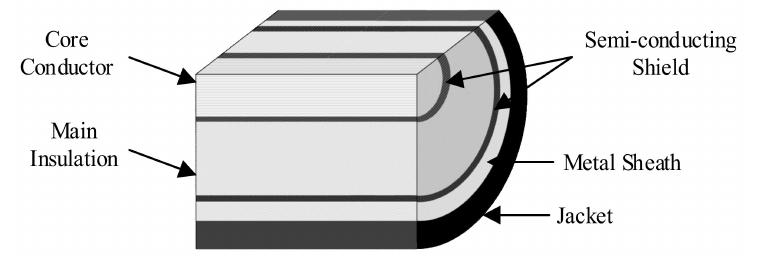
Figure 1. A typical structure of a single-core power cable.